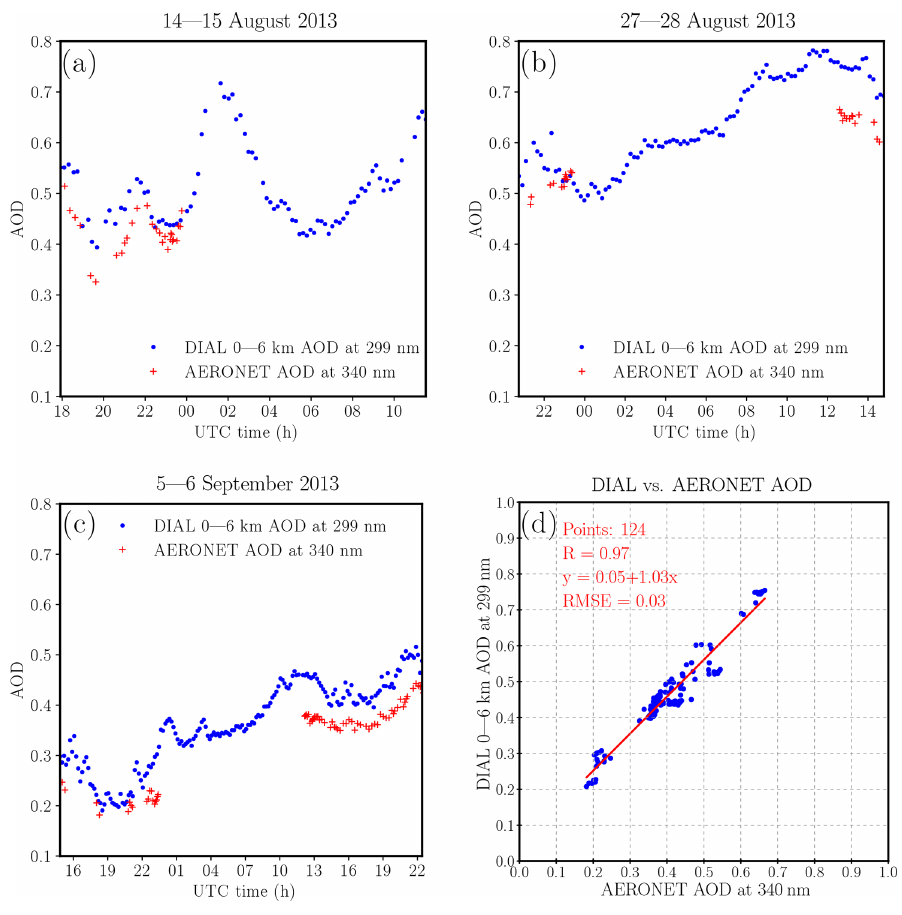
Figure 2. RO 3 QET DIAL-derived AOD between 0 and 6km at 299nm using S = 60sr compared to colocated AERONET AOD at 340nm for (a) 14–15 August, (b) 27–28 August, and (c) 5–6 September 2013. (d) Regression of the paired data after the DIAL AOD is interpolated to the times of AERONET AOD